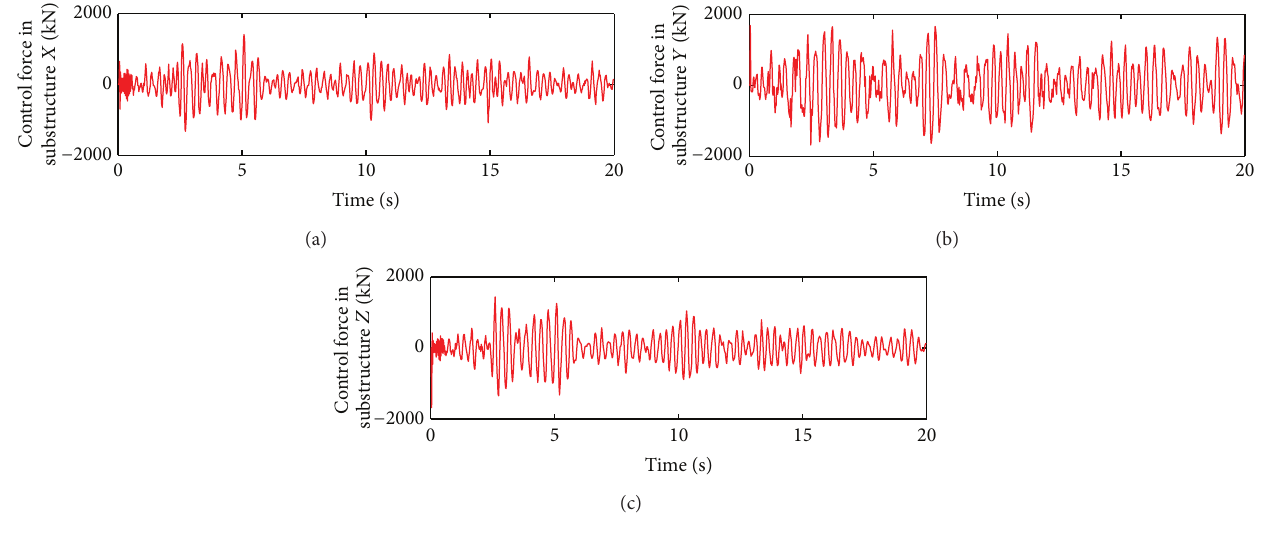
Figure 21: Control force time history of